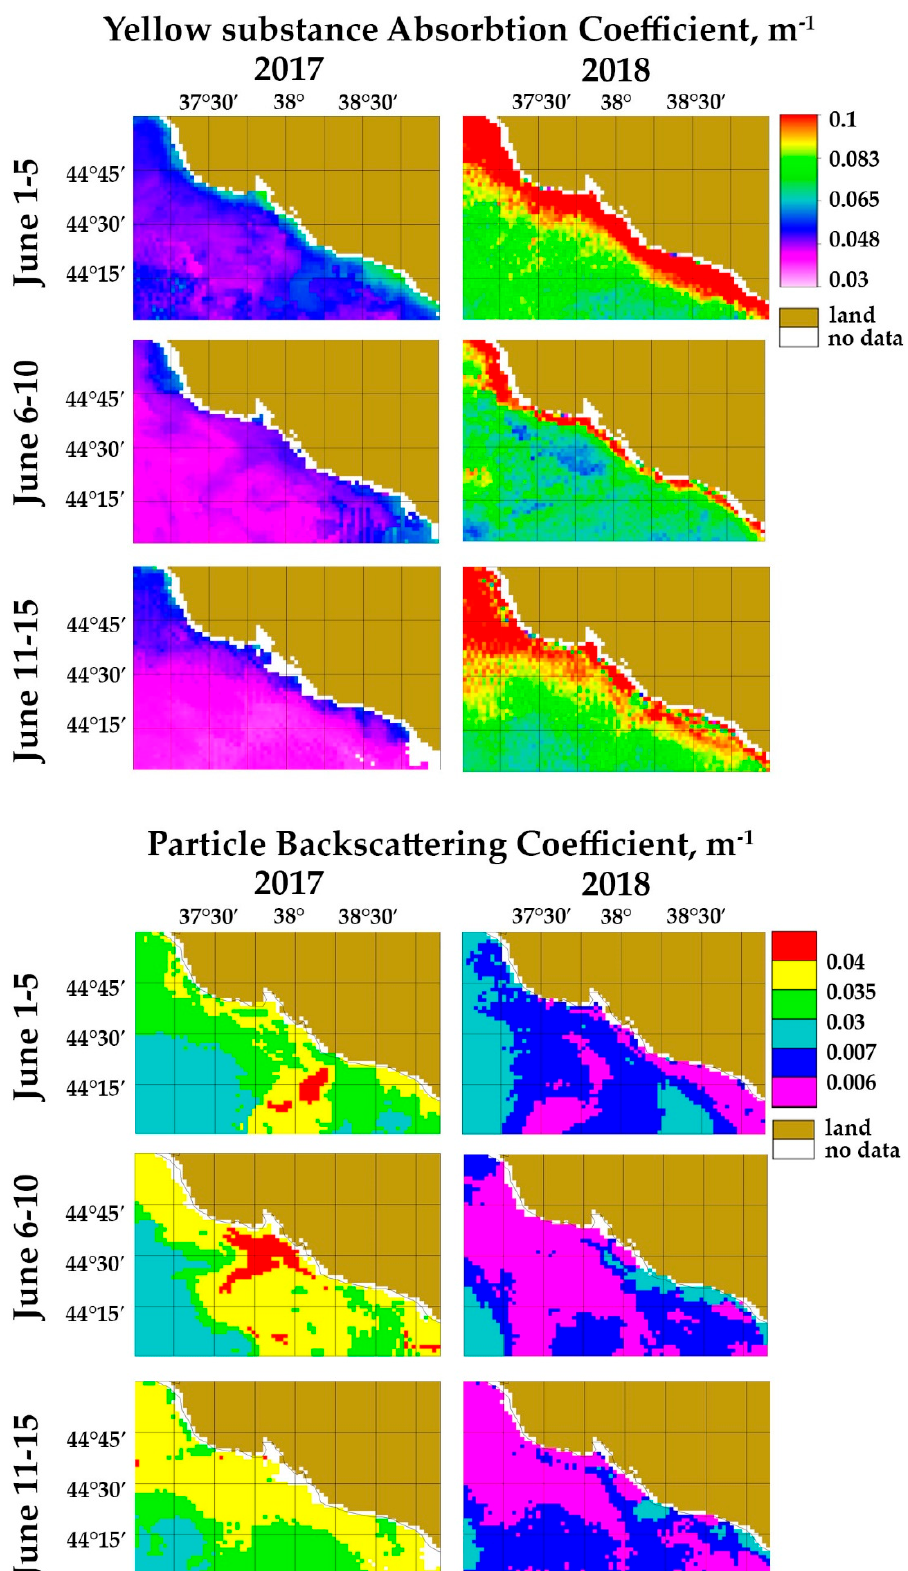
Figure 3. The spatial distributions (from top to bottom) of values of the yellow substance absorption coefficients a g and particle backscattering coefficients b bp derived from Moderate-Resolution Imaging Spectroradiometer (MODIS)-Aqua data of 1–15 June 2017 and 2018.